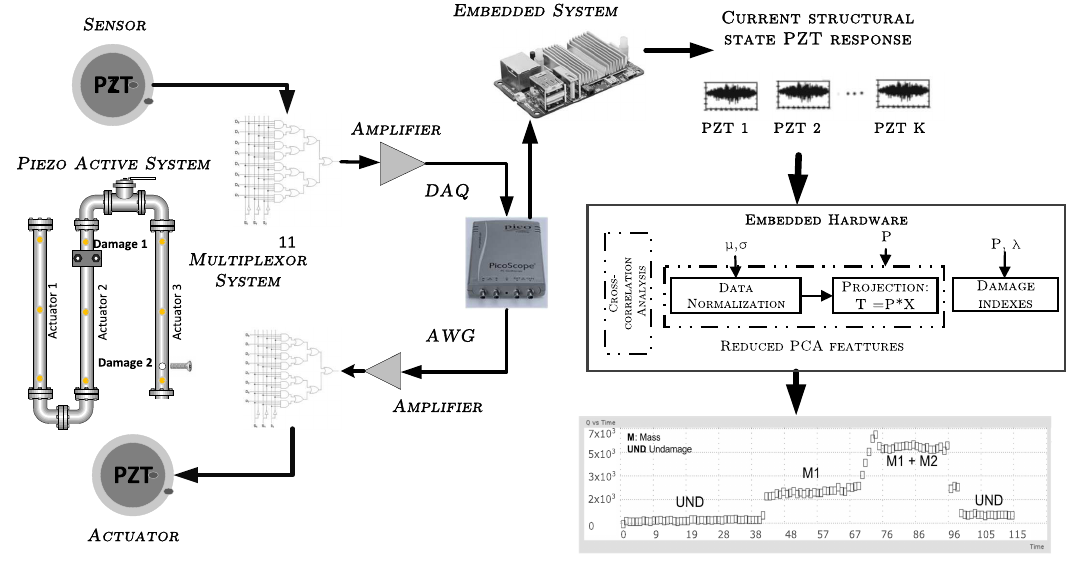
Figure 4. Logical relationship configuration